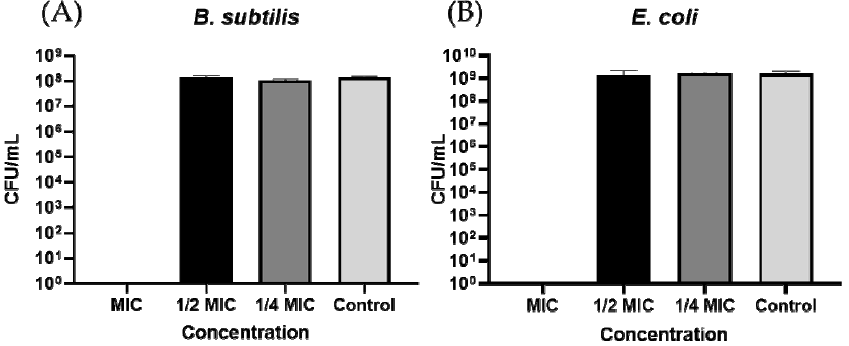
(CFU) per mL were counted after treatment with MIC, 1 / 2 MIC, 1 / 4 MIC and no treatment (Control). Each bar presents the mean of three replicates ±